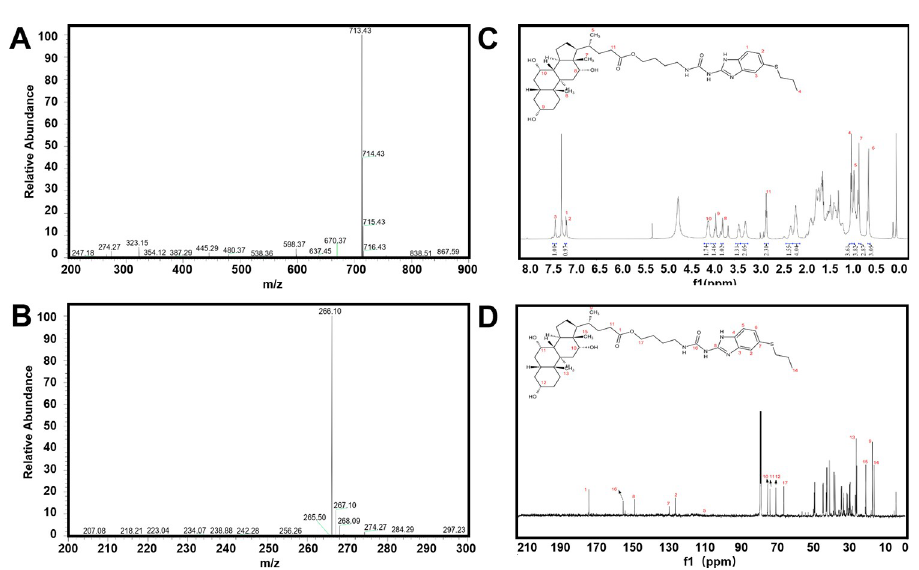
Fig 3. Structural identification of ABZ-BA. (A) High-resolution mass spectrum of ABZ-BA. (B) High-resolution mass spectrum of ABZ. (C) ABZ-BA 1 H-NMR spectrum. (D) ABZ-BA 13 C-NMR spectrum.